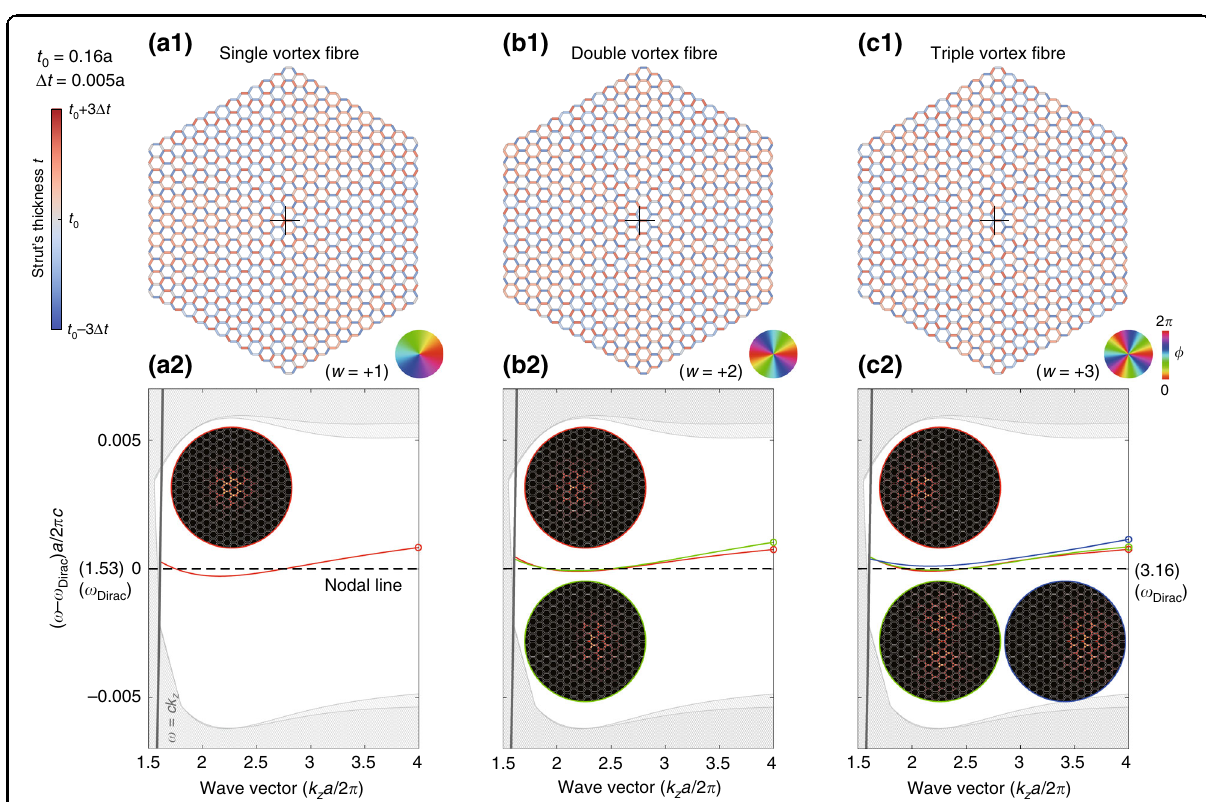
Fig. 4 Continuous Dirac-vortex fi bres with winding number w = + 1, + 2, + 3. ( a1 ), ( b1 ), and ( c1 ) are the fi bre structures. The colour wheels show the corresponding phases of the generalised Kekulé modulation. ( a2 ), ( b2 ), and ( c2 ) are the corresponding band diagrams, and the insets show the mode pro fi les ( b z (cid:2) Re ½ E (cid:3) ´ H (cid:4) ) of modes at k z a /2 π =